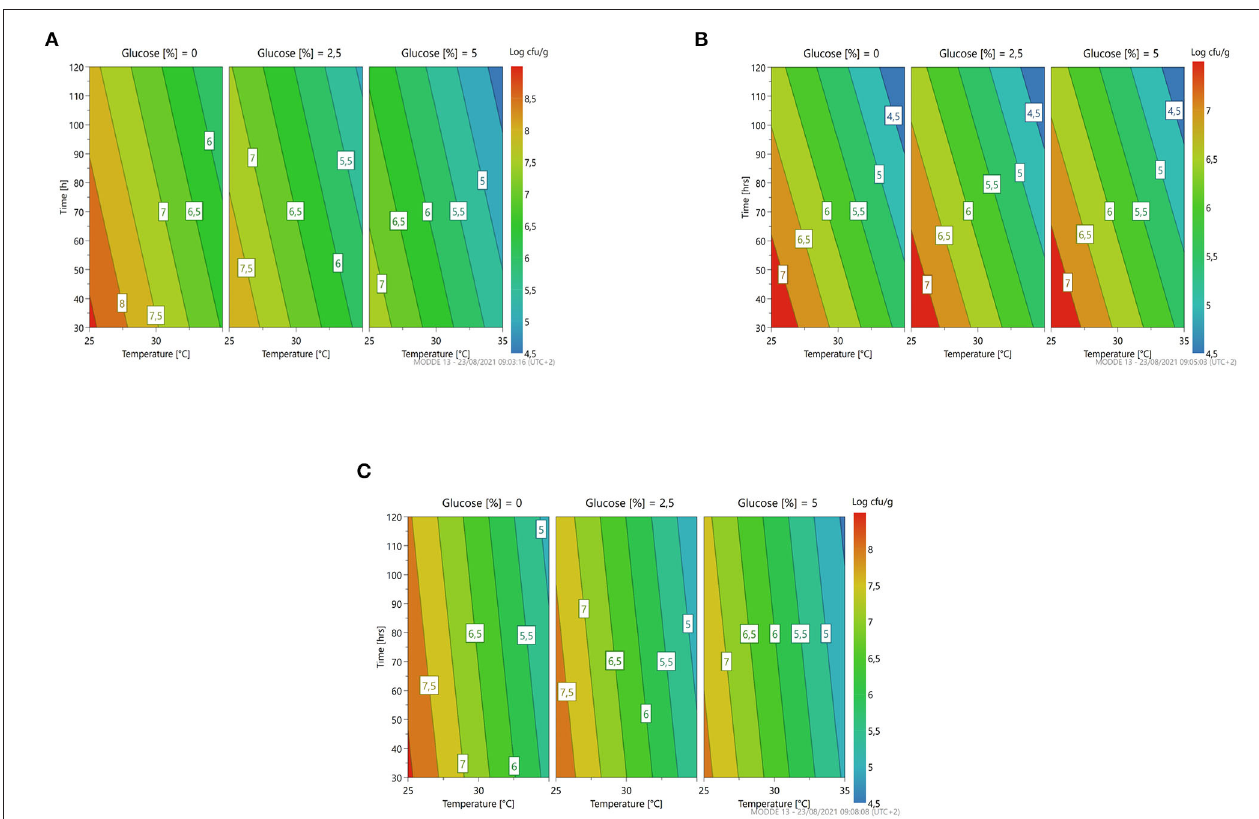
FIGURE 6 | A response contour plot of concentration (Log cfu/g) of Leuconostoc citreum 4452 (A) ; Leuconostoc mesenteroides 2194 (B) ; Weissella minor 4451 (C) in the sample with seeds, with time and temperature as main factors and with glucose variation.